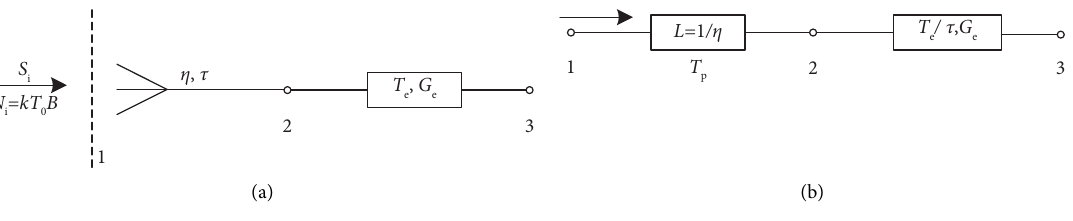
Figure 6: Noise model of radiating antenna.